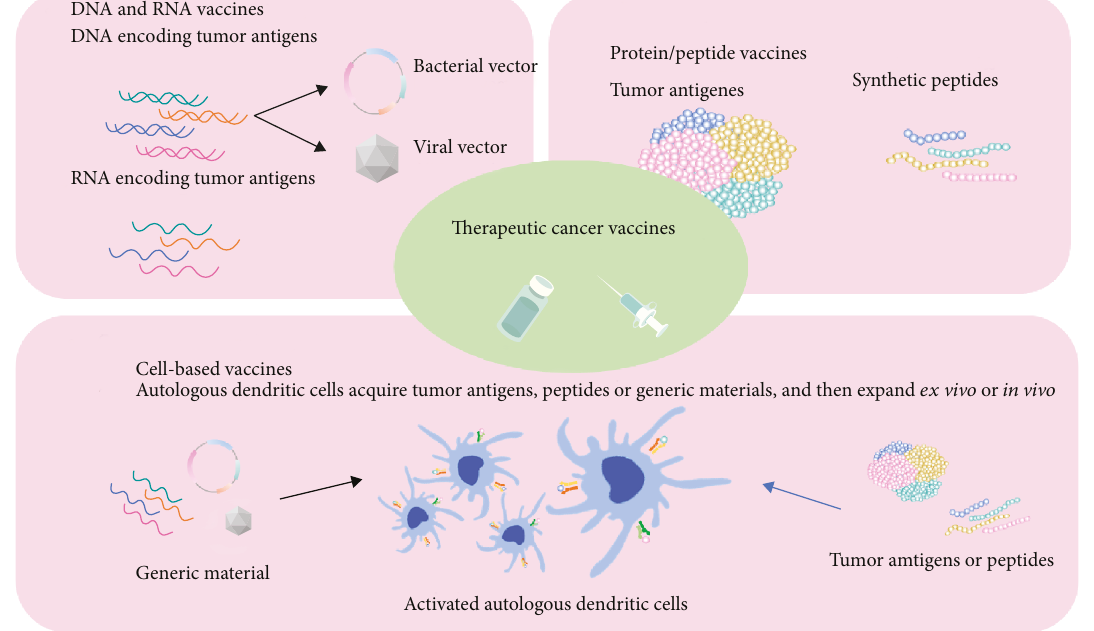
Figure 1: Schematic representation of di ff erent types of therapeutic cancer vaccines, which could be designed according to the forms of cells, proteins/peptides, and